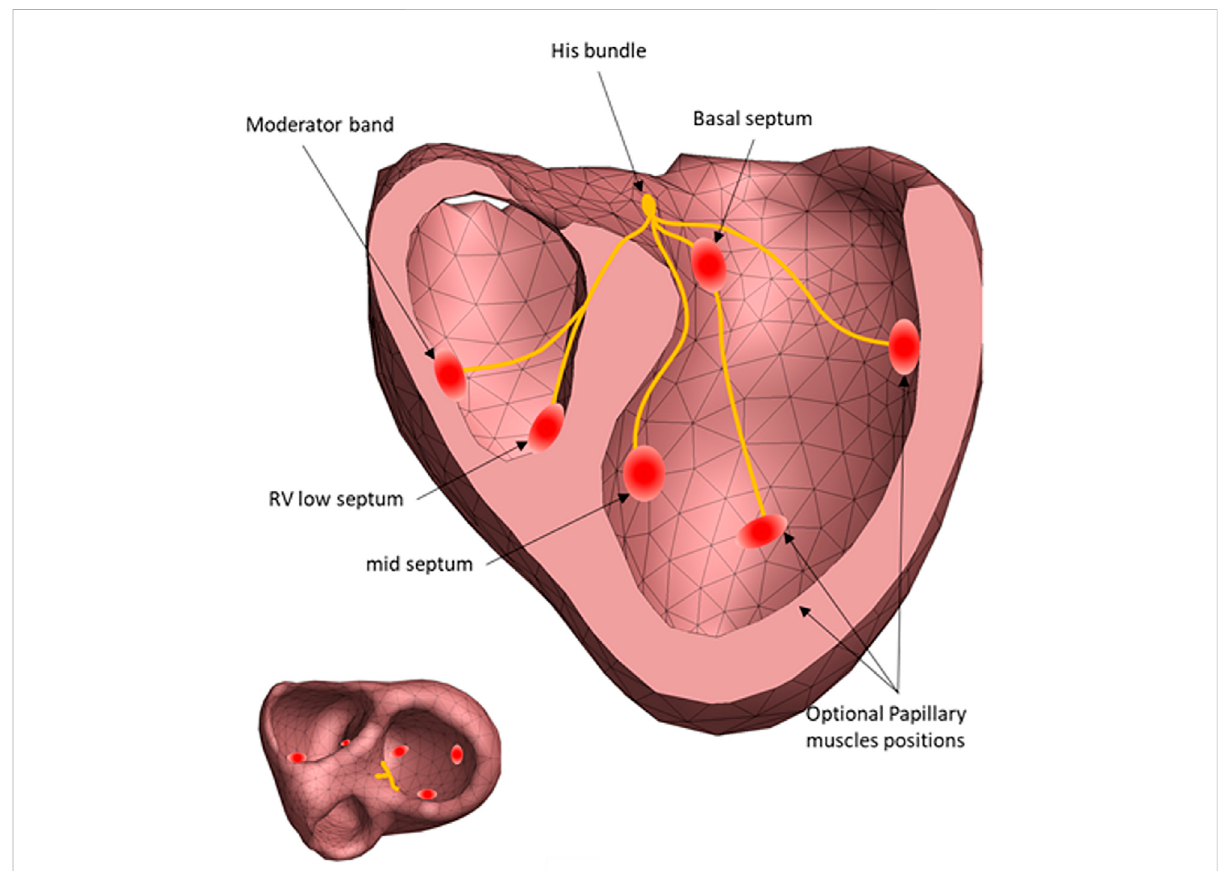
FIGURE 2 The regional sites of early activation associated with the Purkinje activation. Each red circle identi fi es a position of the initial estimation of the cardiac activation. The exact position of the His-Purkinje system is unknow, only the effect of the His-Purkinje system on cardiac activation is simulated (left panel). 15 .